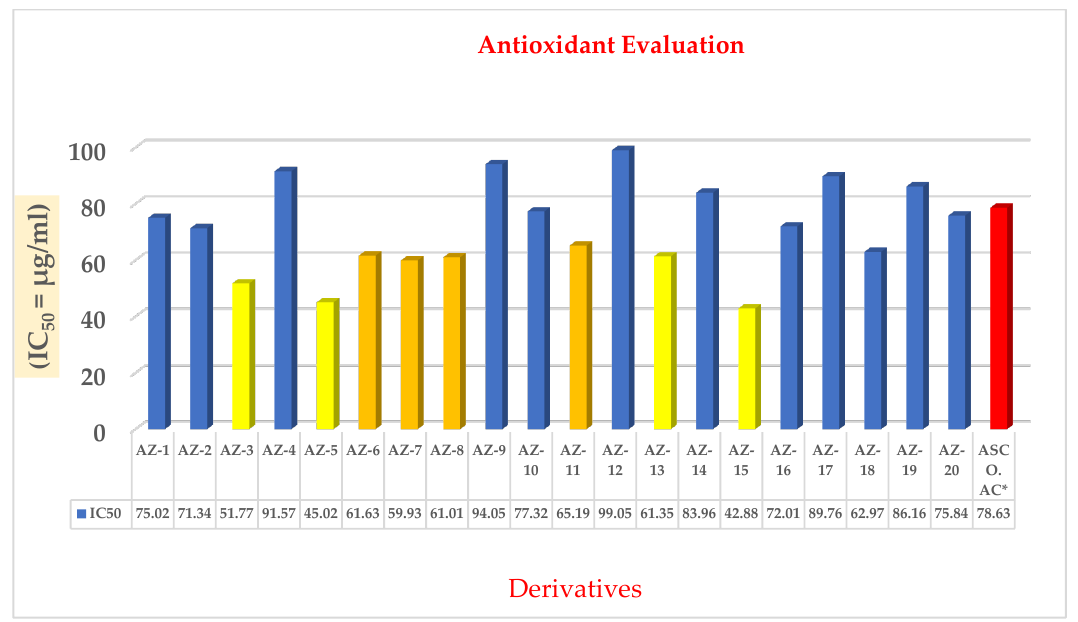
Figure 6. Antioxidant potentials of the synthesized derivatives. *-Standard drug=Ascorbic acid.